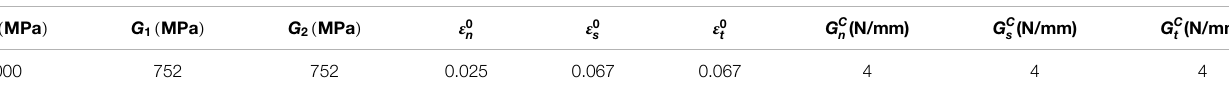
TABLE 3 | Material parameters for cohesive behavior (Lapczyk and Hurtado,